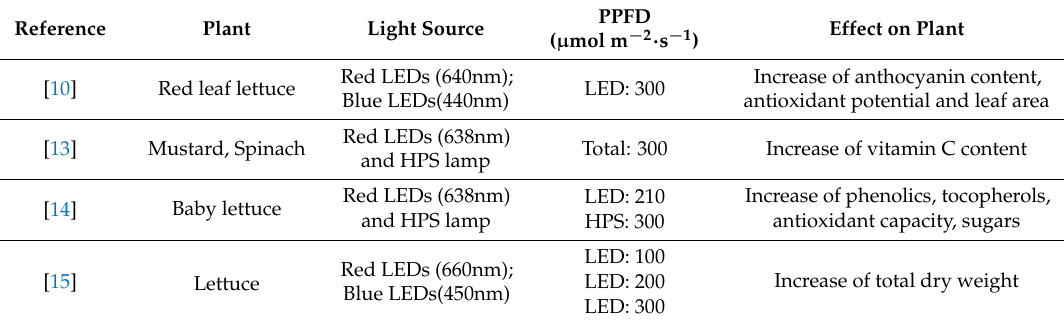
Table 2. Effects of light sources with the different photosynthetic photon flux density (PPFD) on the plant.